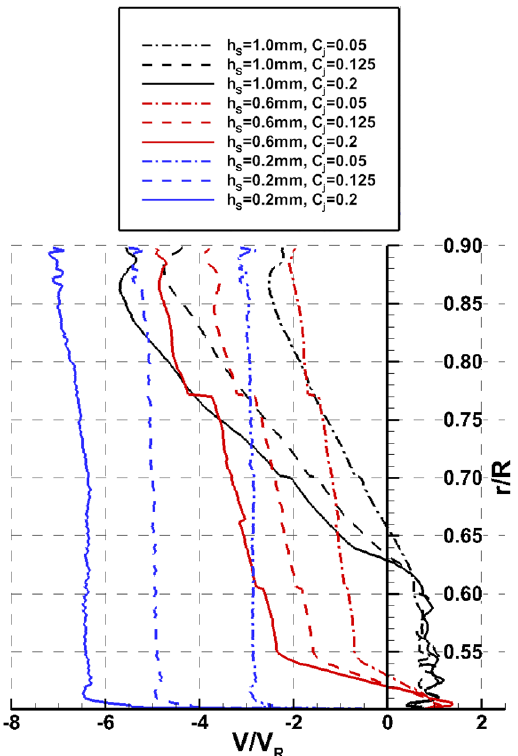
Figure 16. Tangential velocity distribution at the center of the slit according to C j for each slit height.